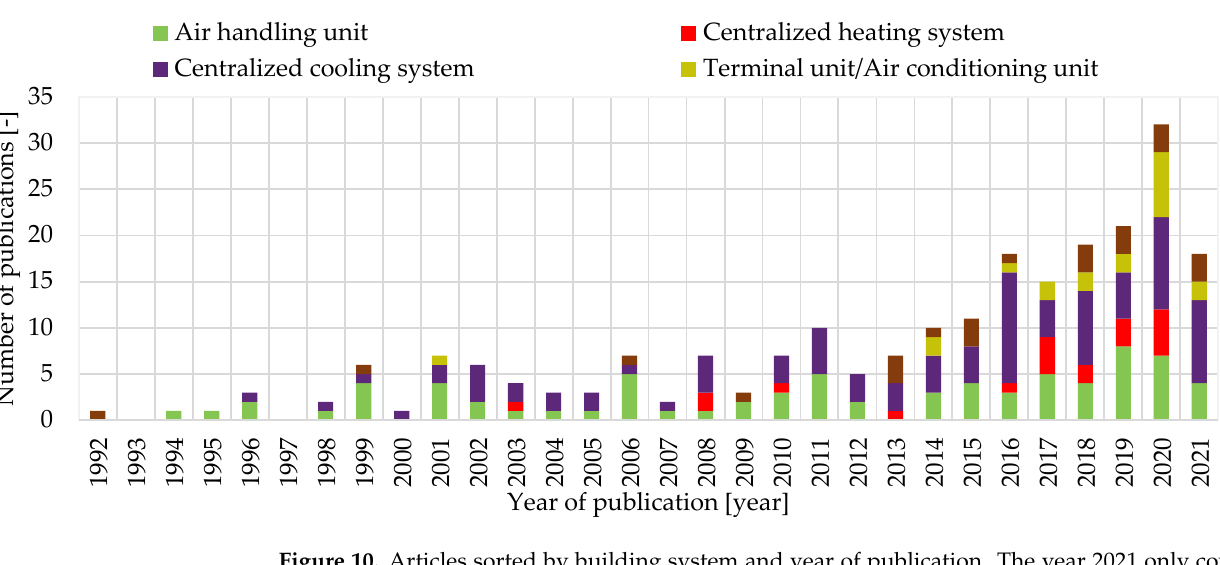
Figure 9. Number of articles within each EST group and building system.